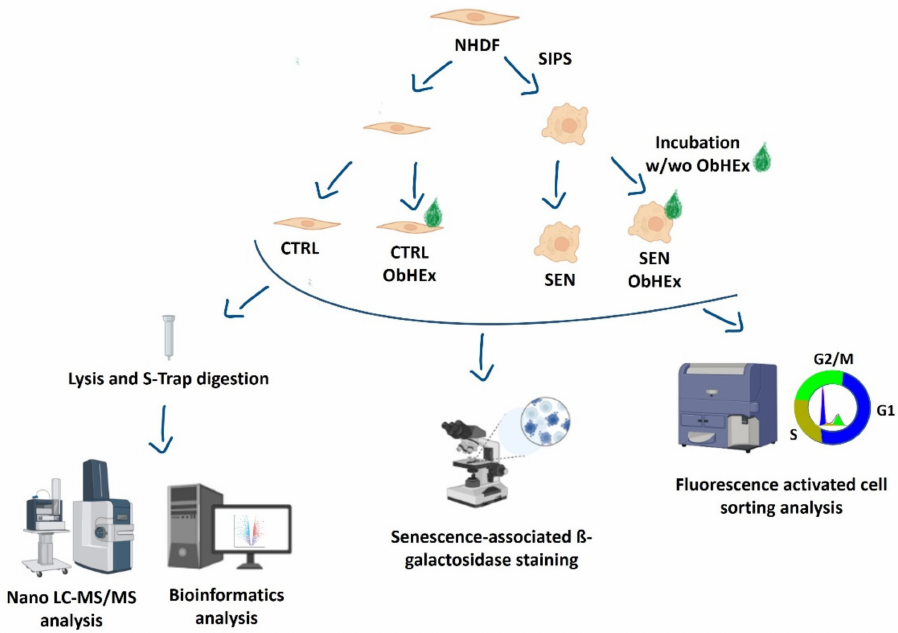
Figure 1. Summary scheme (created with BioRender.com accessed on 12 November 2022) of the adopted